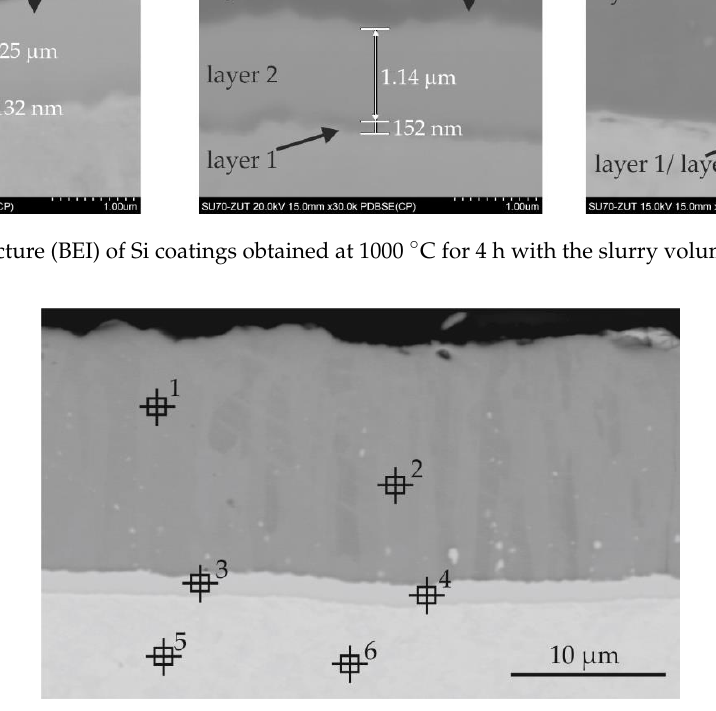
Figure 6. Microstructure (BEI) and point X-ray microanalysis is of Si coating obtained on TZM alloy for 6 h at 1000 °C with the slurry volume of 0.3 g/cm 2 . Table 2. The results of the EDS point analysis of Si coating according to Figure 6. Point of Analysis